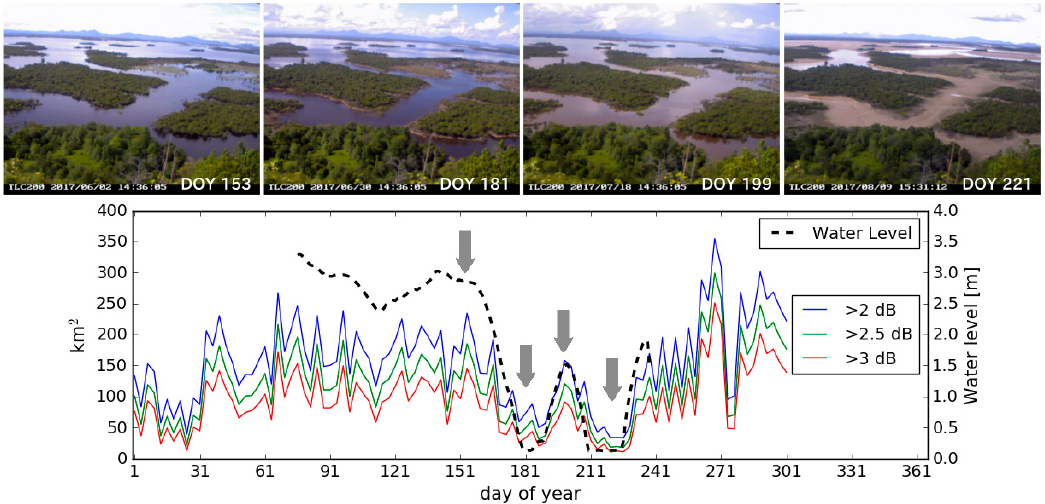
Figure 8. Upper row: Wetland photos taken by the time-lapse camera in 2017. Lower row: Comparison of water gauge data and area of possible seasonal wetlands. The blue, green, and red lines were calculated as described in Figure 7. The dashed line is the water level (m), which was available from March to August 2017. The gray arrows indicate the date the wetland photos were taken.